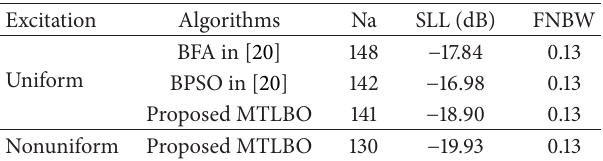
Table 1: The SLL reduction in regular 𝑢 - V space performance comparison of different